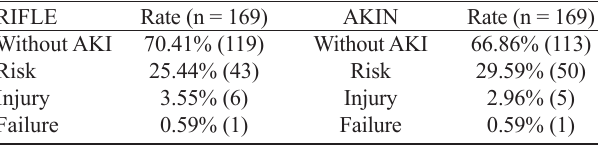
Table 3. Incidence of AKI stratified by RIFLE and AKIN criteria.